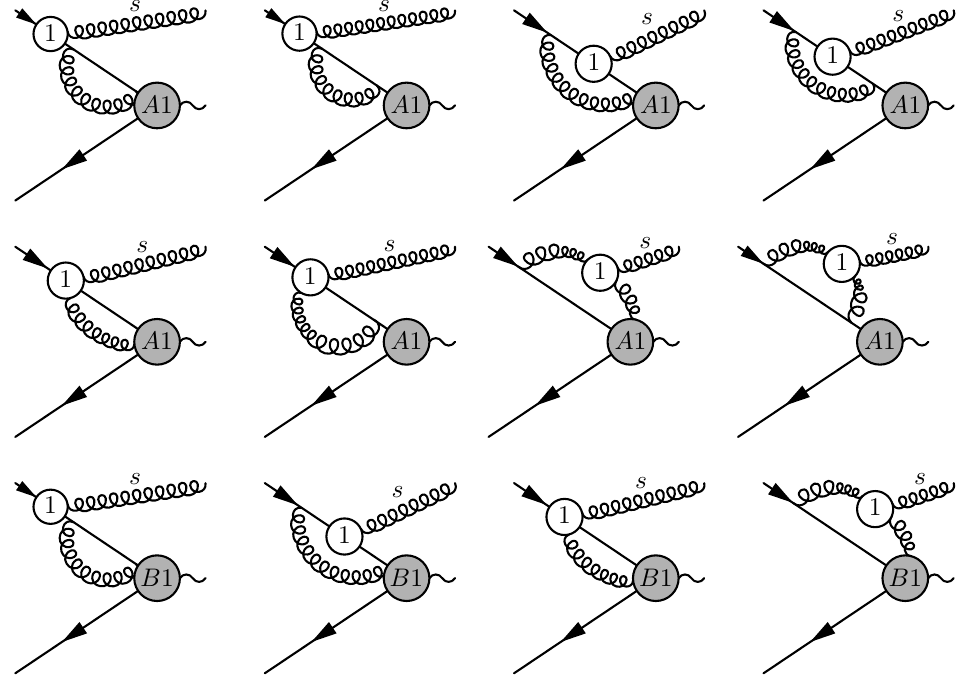
( (cid:21) 1 ) power-suppressed O gluon (cid:12)eld present in this A c ?